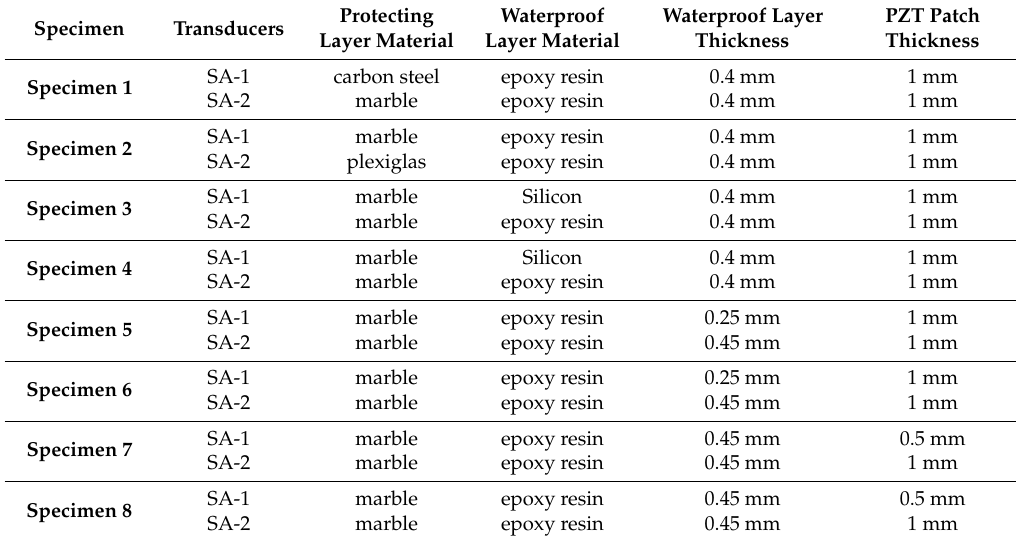
Table 3. Test specimens.